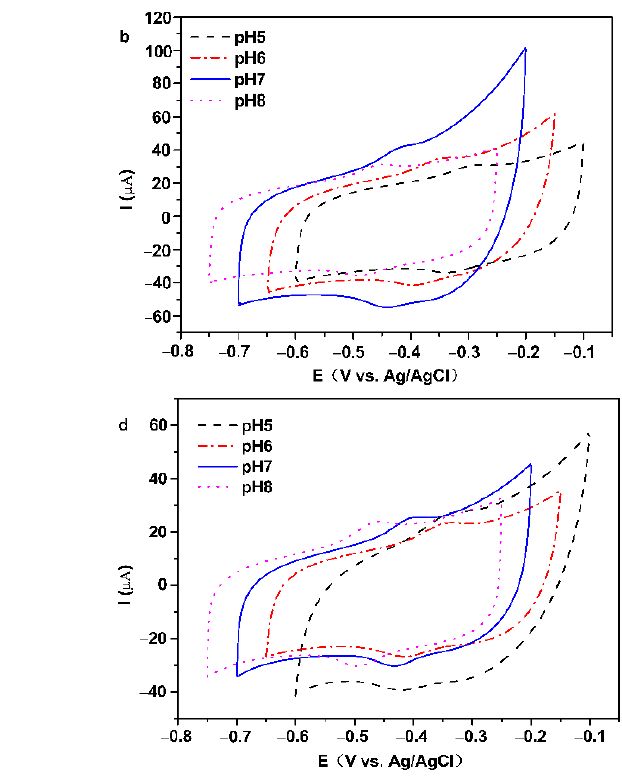
Figure 7. The CV curves of Nafion/GOD/FeOOH-GA 0.125 /GCE ( a ), Nafion/GOD/FeOOH-GA 0.25 /GCE ( b ), Nafion/GOD/FeOOH-GA 1.0 /GCE ( c ) and Nafion/GOD/FeOOH-GP/GCE ( d ) in various pH values of electrolyte with 50 mV s − 1 scan rate.